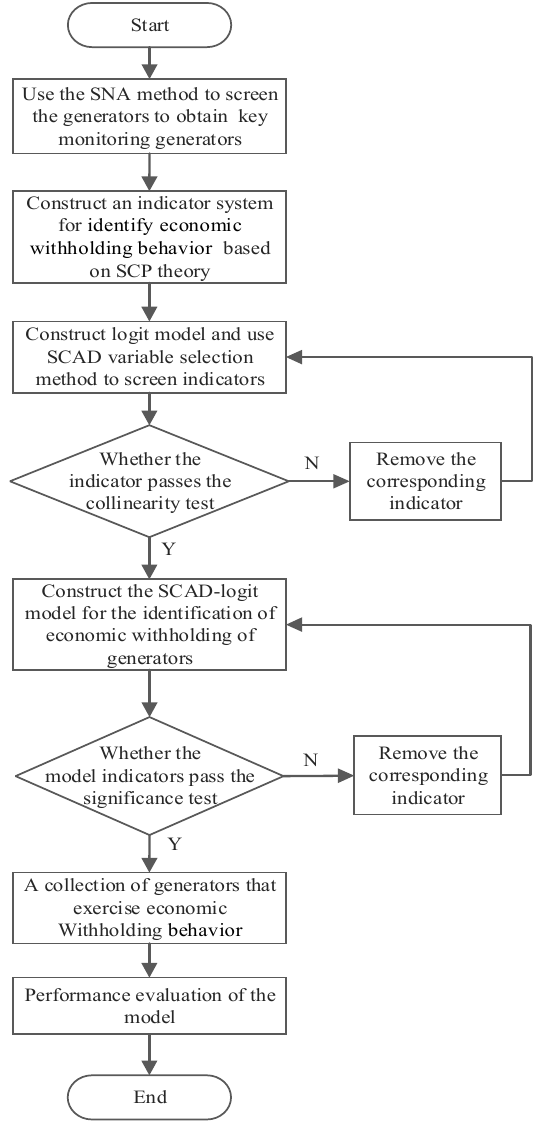
Figure 3. Flow chart of identifying the economic withholding behavior of generators.